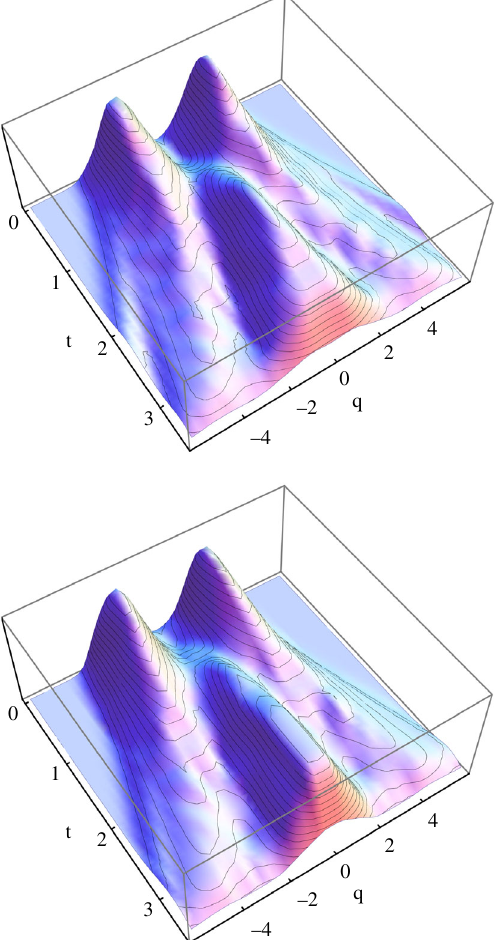
FIG. 7. Smoothed histogram plots of the computed MIW (top) and dBB (bottom) world trajectories for two identical initial Gaussian wave packets in units of the initial spread (i.e., σ ¼ 1 ) and N ¼ 41 worlds; time is given in units of ℏ = ð 2 m Þ